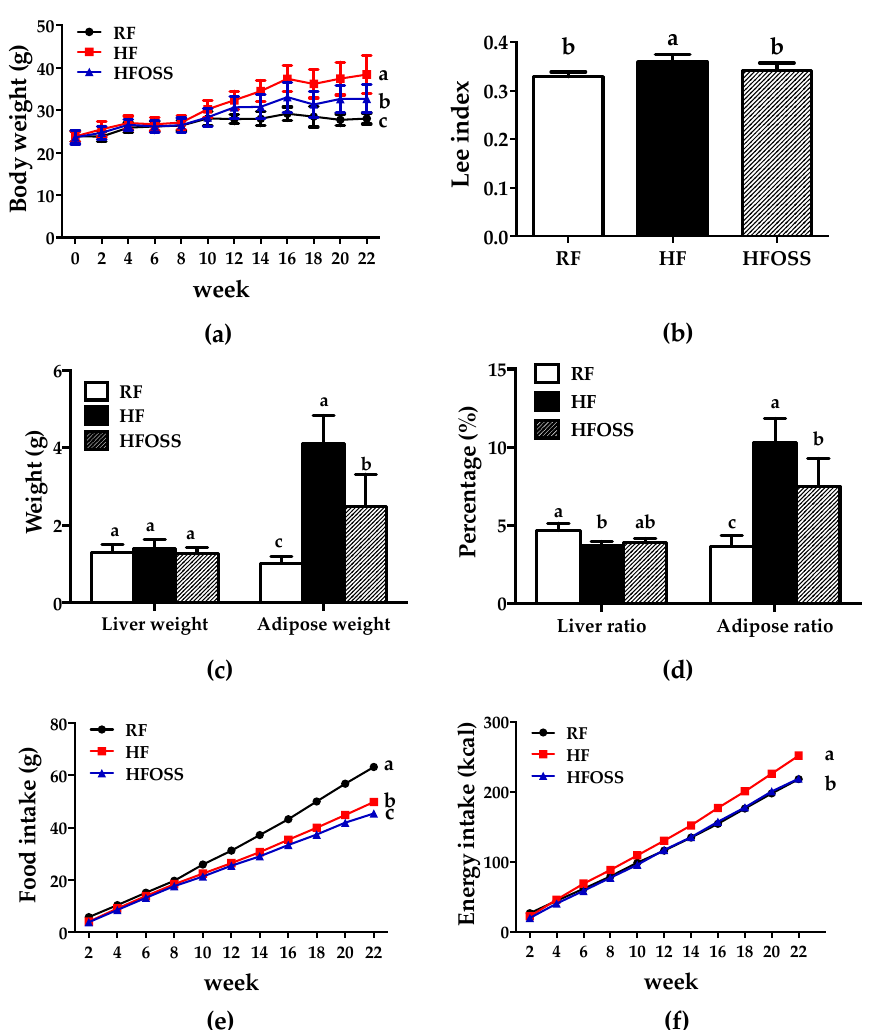
Figure 1. ( a ) Body weight, ( b ) Lee index, ( c ) liver and adipose weight, ( d ) liver and adipose ratio, ( e ) cumulative food intake, and ( f ) cumulative energy intake of mice fed a regular-fat diet (RF), high-fat diet (HF) and high-fat diet supplemented with OS starch (HFOSS). Values with different letters indicate significant differences between groups ( p < 0.05).